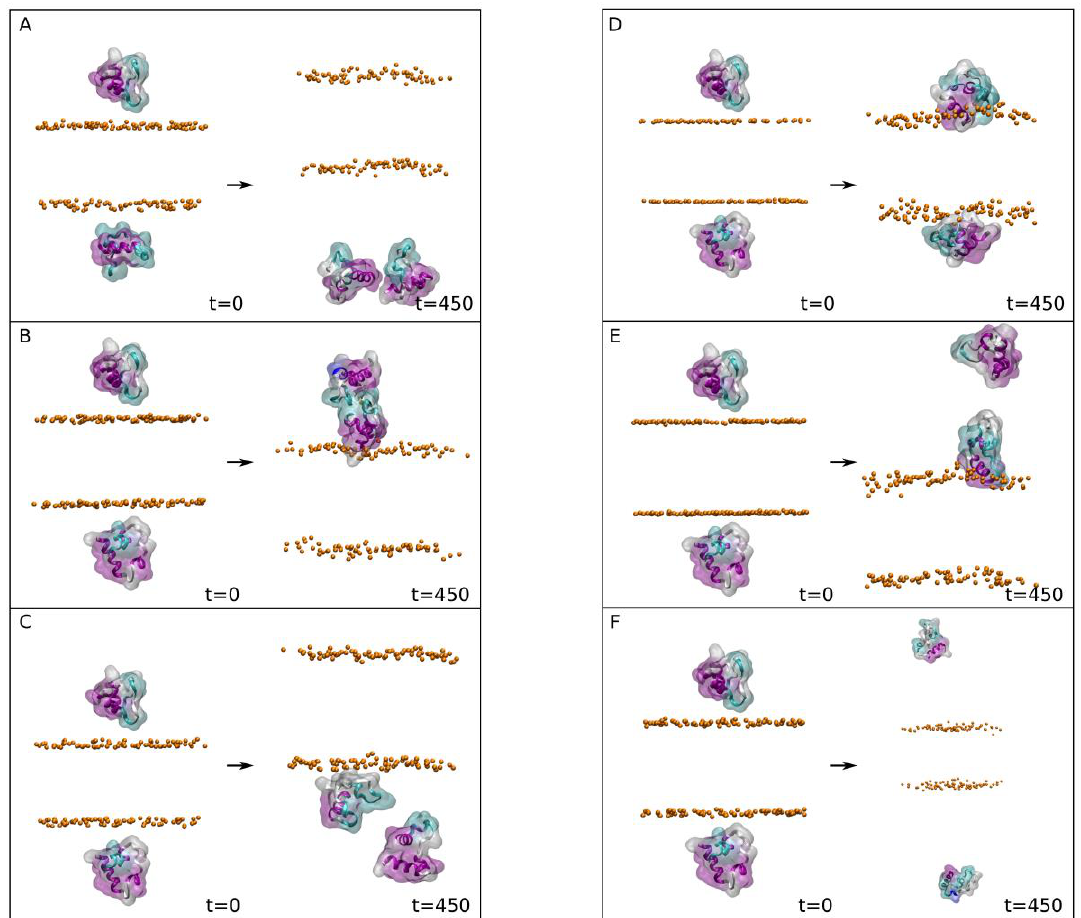
Figure 3. Initial (left) and final (right) arrangements corresponding to the second step (systems 2-7 to 2-12) for systems containing ( A ) POPC/CHOL, ( B ) POPE/CHOL, ( C ) POPS/CHOL, ( D ) PI- 3P/CHOL, ( E ) BMGP/CHOL and ( F ) PSM/CHOL in the presence of 0.15 M CaCl 2 (MD time 450 ns). The peptides are shown in both ribbon and surface transparent drawing style with coloured secondary structures (white (coil), violet (helix), yellow (extended), light blue (turns)). The surrounding phospholipid phosphate atoms are shown in VDW drawing style (orange). The water molecules and the chloride and calcium ions have been removed for clarity.